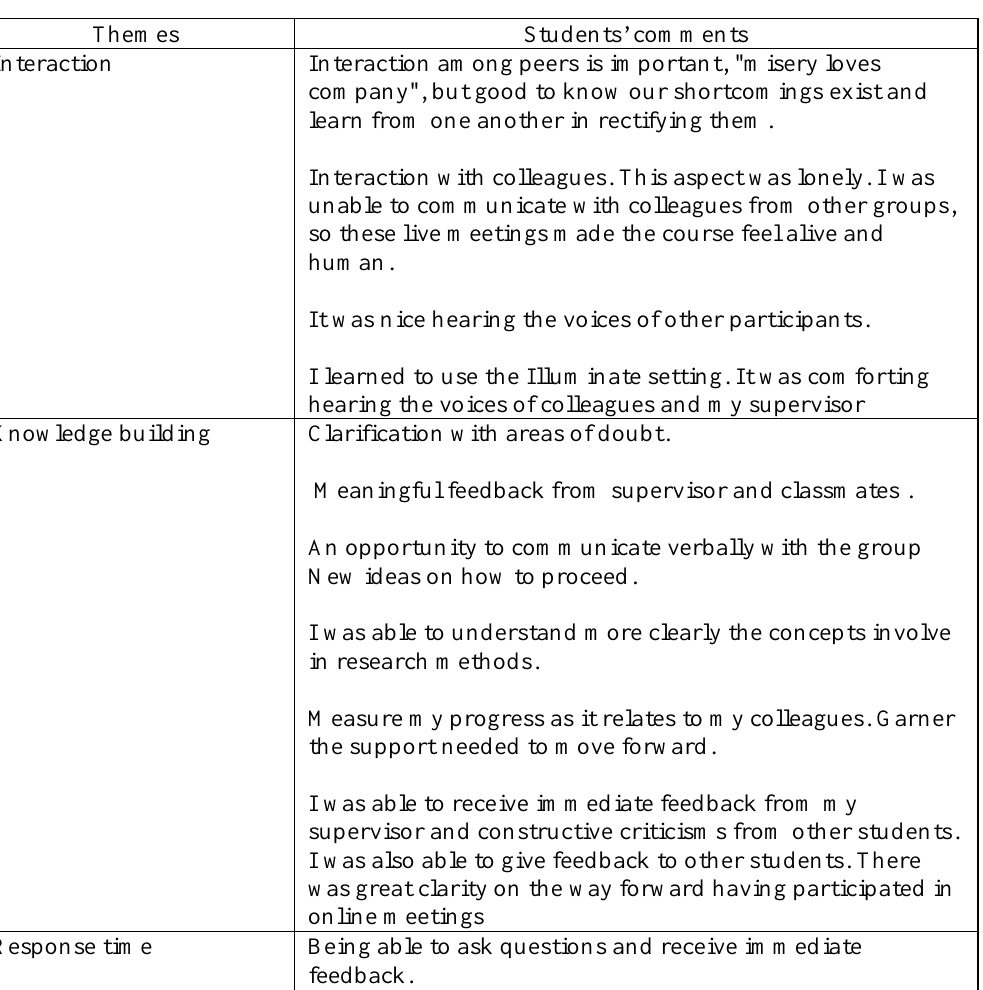
Table 2 Showing the Dominant Themes that Emerged with the Implementation of Live Online Seminar Sessions Using Blackboard Collaborate